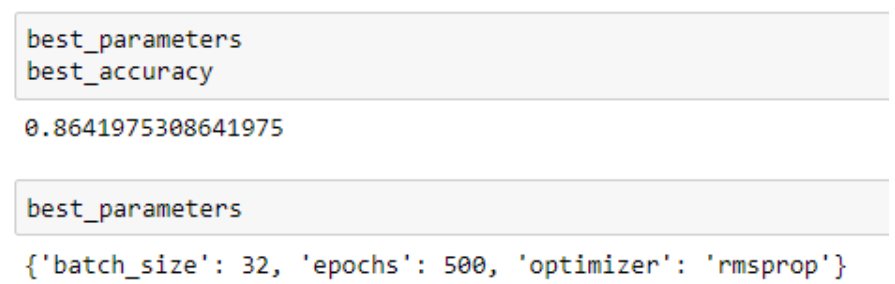
Figure 35. The accuracies achieved by the Folds after performing 10-Fold Cross-Validation on the ANN (3-6-6-1) model.